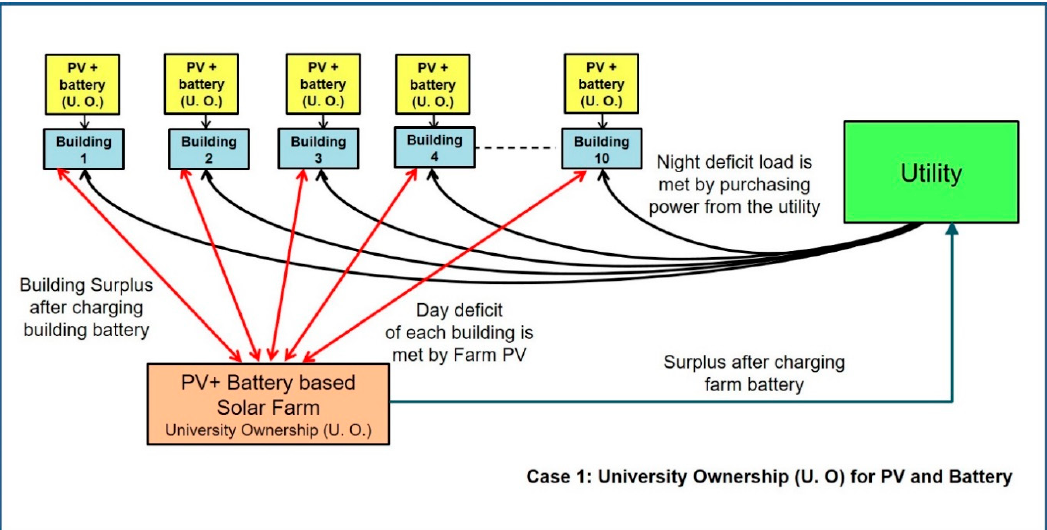
Figure 12. Financial analysis based on the fact that the university is the owner of the entire power network based on photovoltaics and batteries. It is assumed that under the existing agreement, the utility can supply the deficiency of power generated by the PV and battery system.